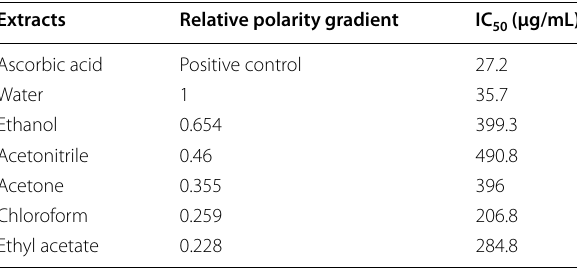
Table 2 Scavenging activity of H. erinaceus extracts with different solvents according to DPPH technique Extracts Relative polarity gradient